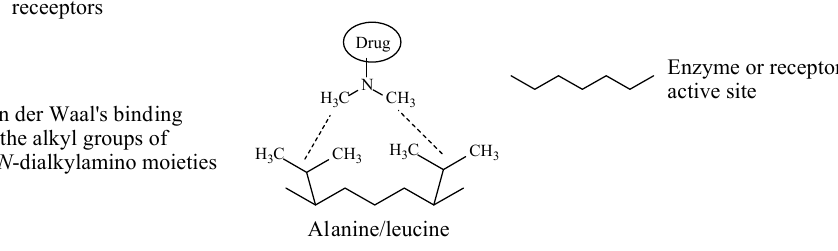
Figure 2. Alkylamino moiety binding to receptors.